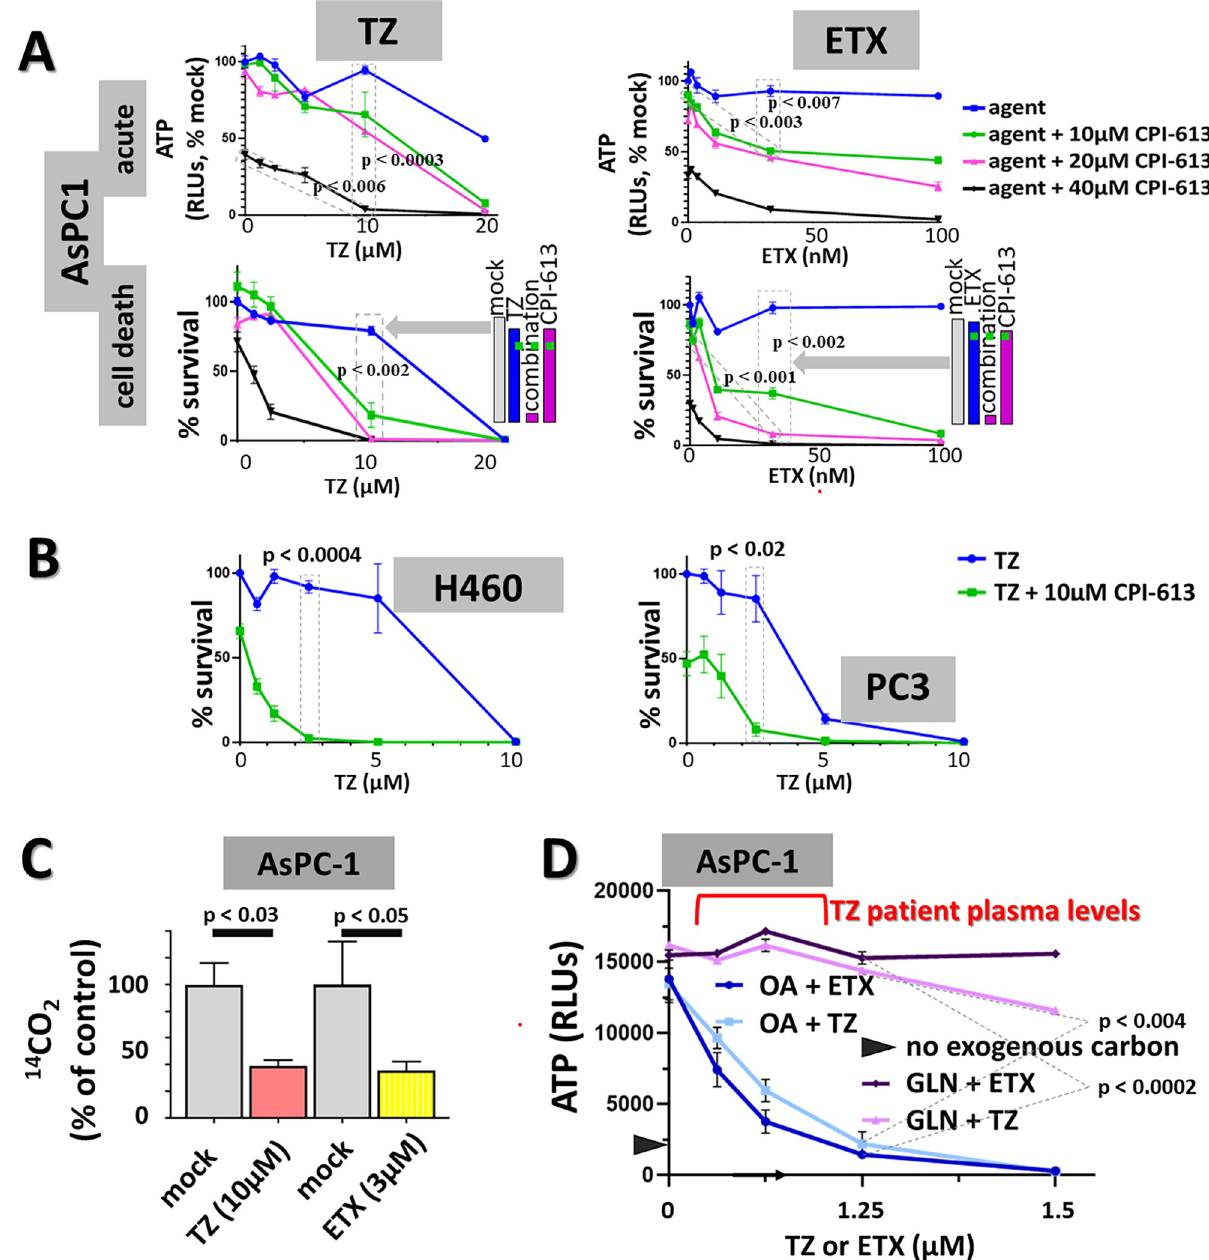
Fig 3. Direct evidence for roles of endogenous lipid stores in determining the sensitivity/resistance of PDAC cell lines to CPI-613. A. Effects of fatty acid beta-oxidation inhibitors on CPI-613 response in resistant AsPC1 cells . Both the peroxisomal inhibitor, thioridazine (TZ) and the mitochondrial inhibitor (ETX) were tested. Assays carried out in exogenous nutrient-free CBS2 as in Fig 1A. Acute measurements were made after 4hrs of treatment. Cell death measurements after 19hrs of treatment followed by 24hrs of CM/ns recovery (legend to Fig 1A). Bar graphs illustrate examples of enhancement effects in boxed point sets indicated by grey block arrows. The dashed green lines indicate expected combination effects if the two agents act independently. See S3A–S3E Fig for additional statistical significance values, bar graph interaction plots, and TZ PANC1 data. B: Thioridazine inhibition of peroxisomal fatty acid catabolism enhances CPI-613 cell killing in other tested carcinoma cell lines . TZ sensitization measurements in lung cancer (H460) and prostate cancer (PC3) cell lines were done as in Panel A cell death measurements except with 21hrs of treatment for H460 and 7 hours for PC3, followed by 22hrs of CM/ns recovery. C: Suppression of OA CO 2 release by thioridazine (TZ) and etomoxir (ETX) . AsPC1 cells were treated in CBS2 with 50 μ M GPi and 40 μ M OA for 1.5 hour in the presence of the indicated concentrations of thioridazine (TZ) or etomoxir (ETX). Samples were then pulsed with addition of 0.1 μ Ci of 14 C-labeled OA during the final 0.5hrs of treatment. CO 2 released by fatty acid oxidation was captured and measured (Materials and Methods and Supplementary Materials and Methods in S1 File). D: Suppression of exogeneous oleic acid-driven rescue from CPI-613 inhibition of ATP synthesis by thioridazine (TZ) and etomoxir (ETX) . Oleic acid (OA; 50 μ M) or